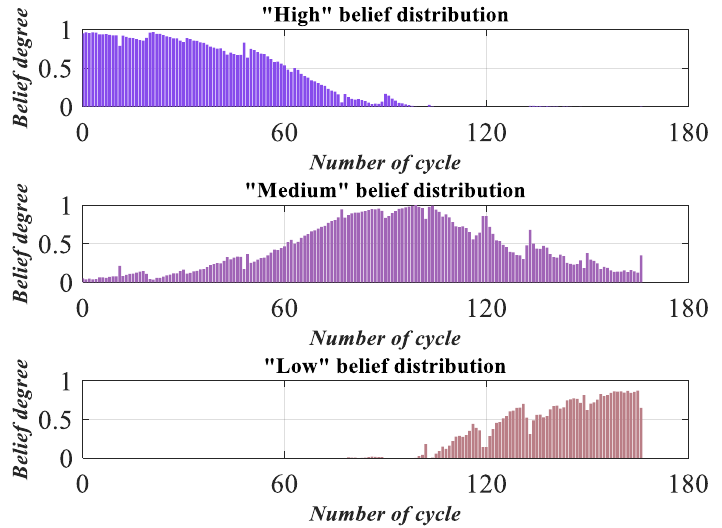
Figure 15. Health assessment result of lithium-ion battery .